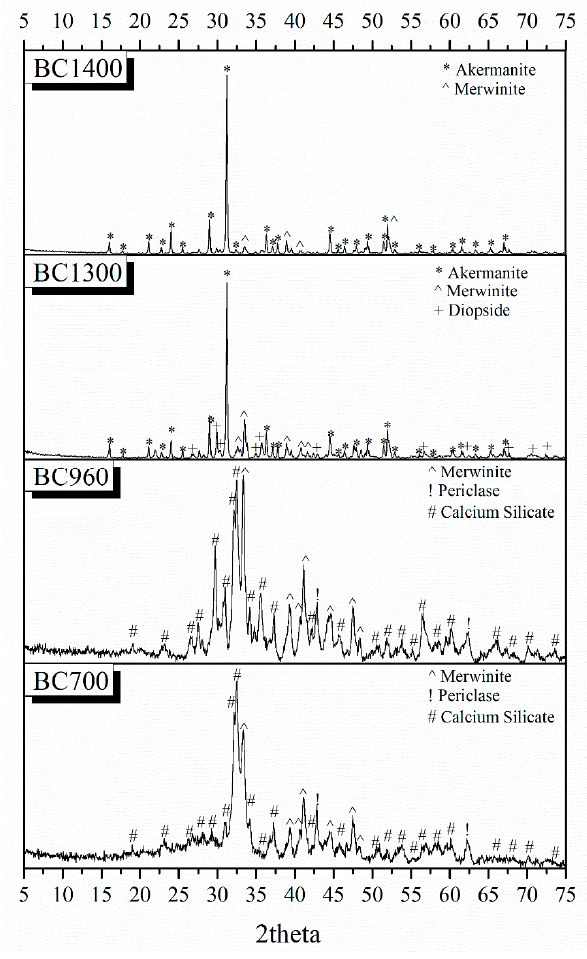
Figure 9. XRD patterns of the bioceramic powders. Table 6 . Quantitative analysis of the XRD patterns in